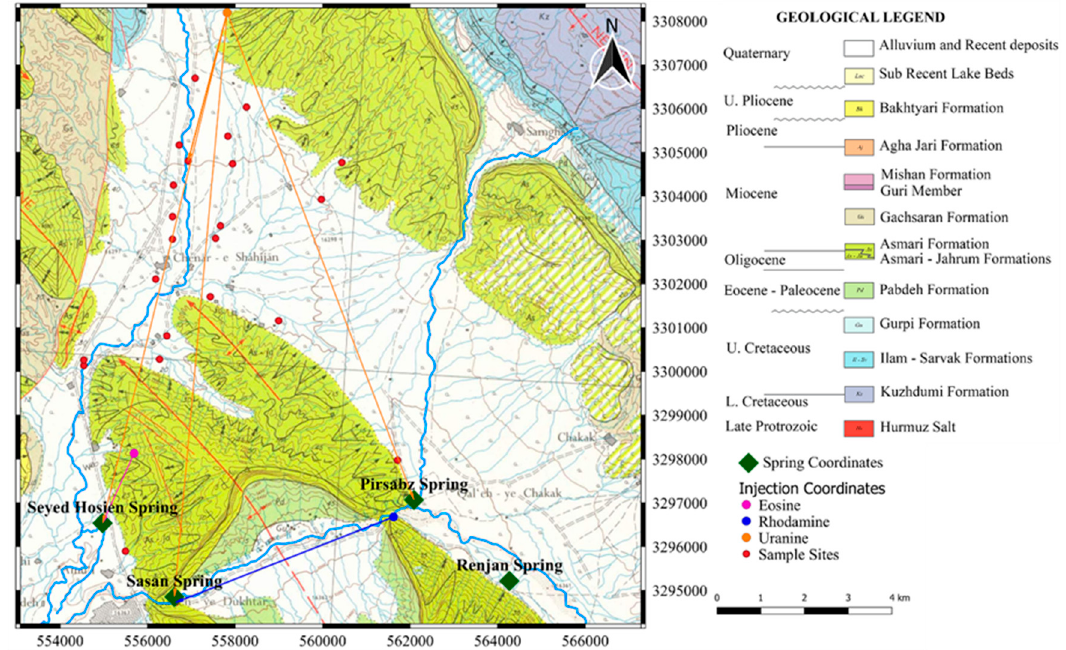
Figure 5. Injection points and sampling locations (modified from [47]).